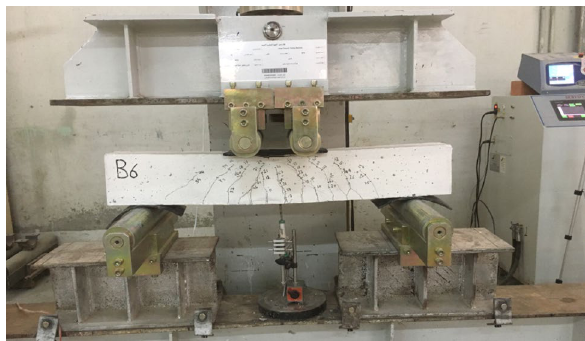
Fig. 3 Setup of beam testing